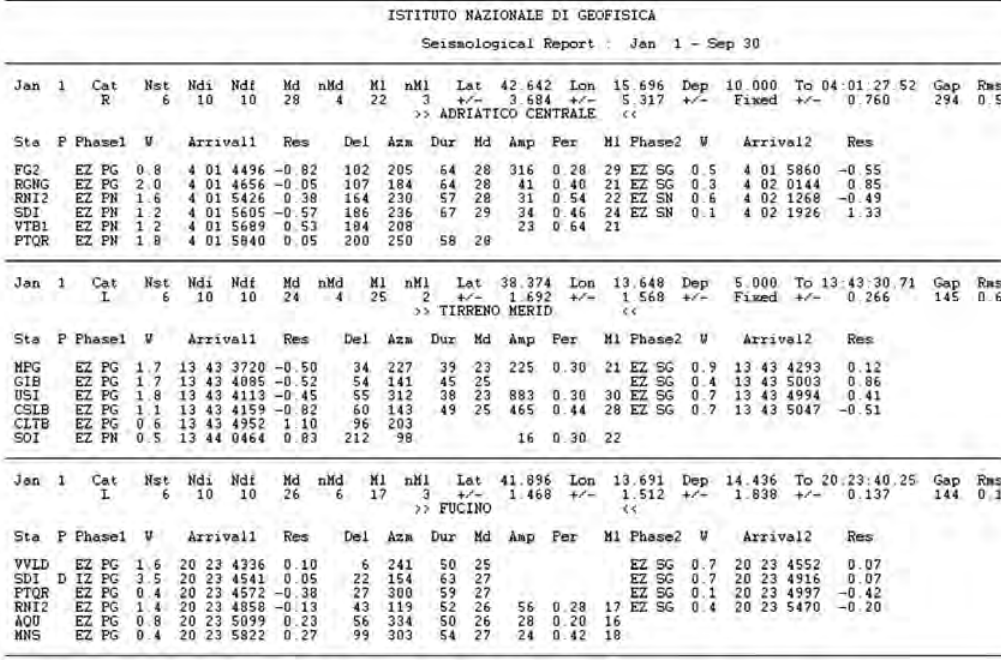
Fig. 10. The first three events of the 2003 INGV